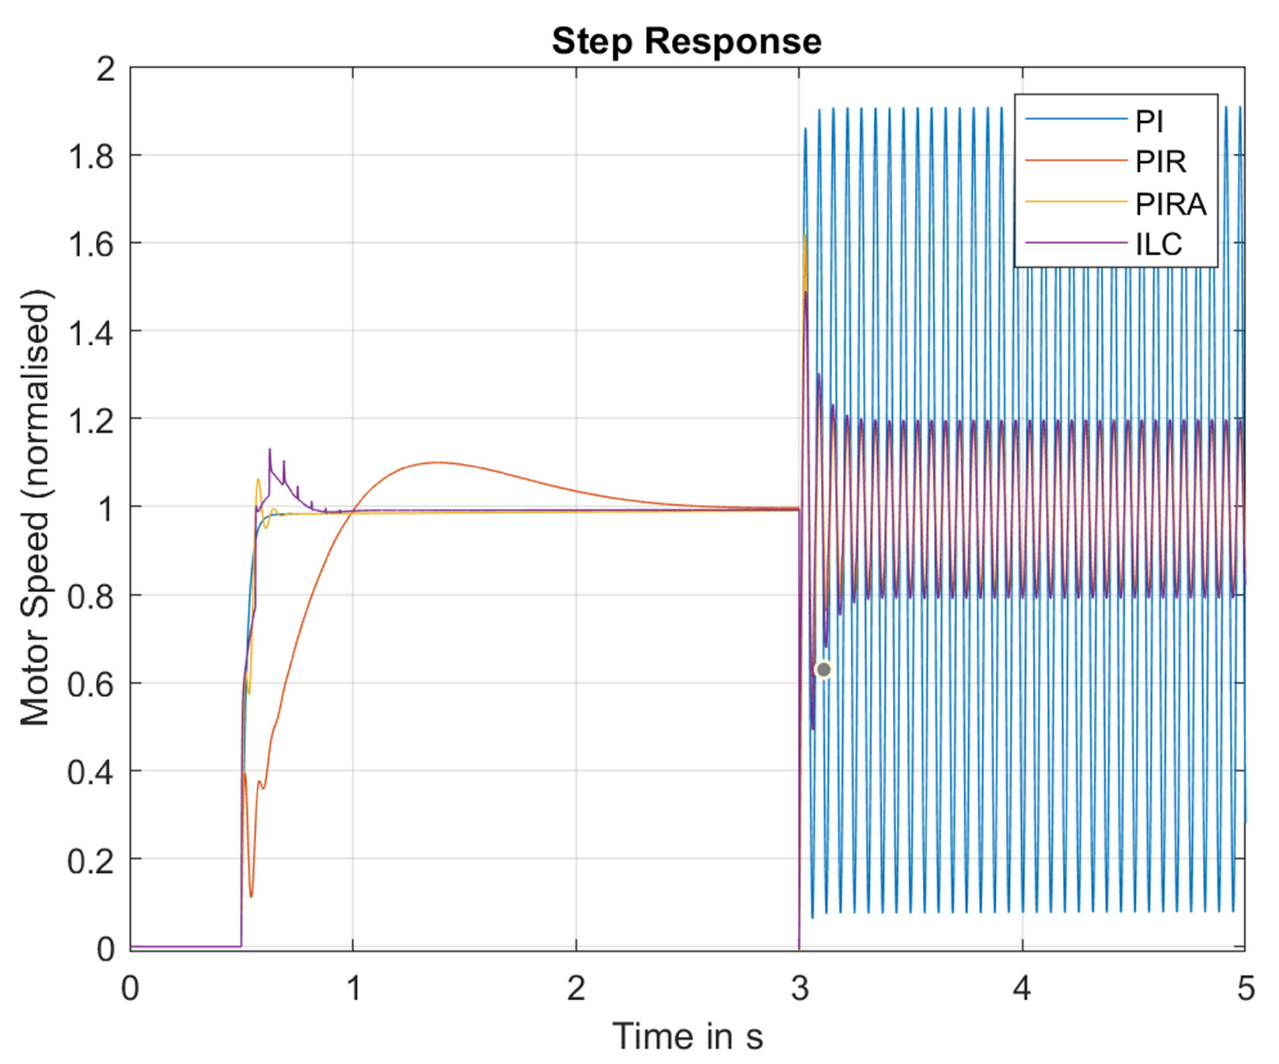
Figure 11. Closed Loop Step Response comparing all three controllers.